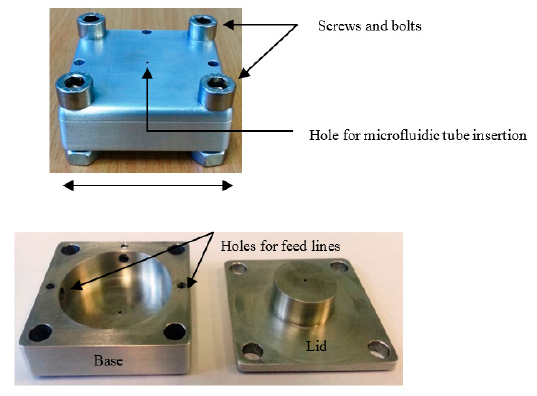
Figure 5. Photograph of the machined re-entrant cavity and its component parts.